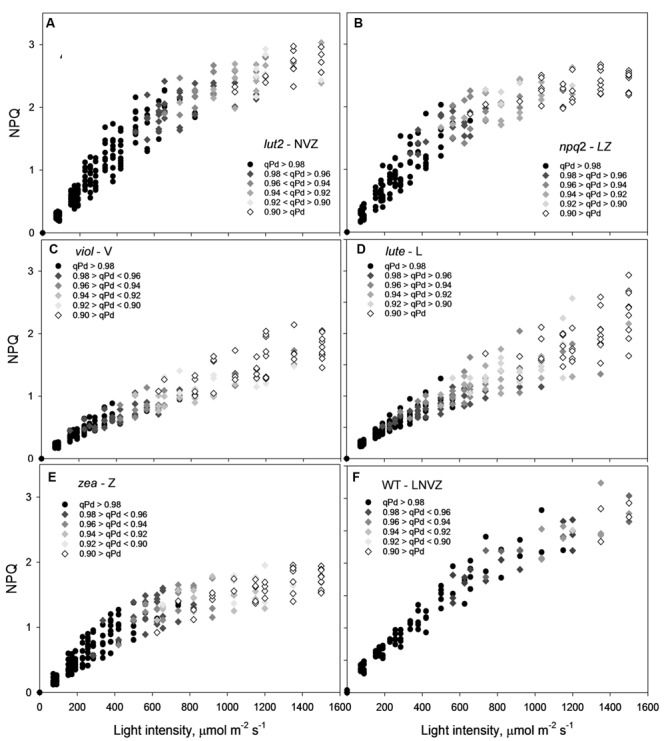
A 3-dimensional representation of the openness of reaction centers, with the corresponding protectiveness of NPQ and AL intensity. Black circles represent leaves where 98–100% of reaction centers are open at a particular light intensity; here NPQ is protective (pNPQ). Greyscale rhomboids represent the degree of reaction center closure (as shown on each panel). Thirty repeats were conducted for each genotype. lut2 – no lutein, npq2 – no violaxanthin and neoxanthin, viol – violaxanthin only, lute – lutein only, zea – zeaxanthin only, WT – wild type.